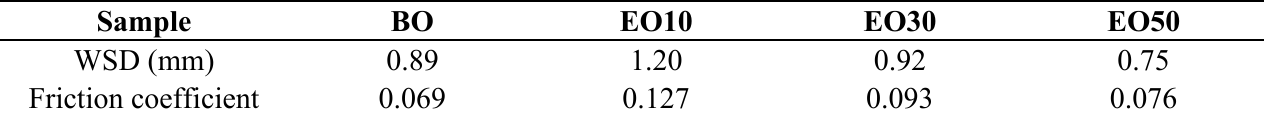
Table 5. WSD and friction coefficient values of the BO, EO10, EO30 and EO50 tested under 392